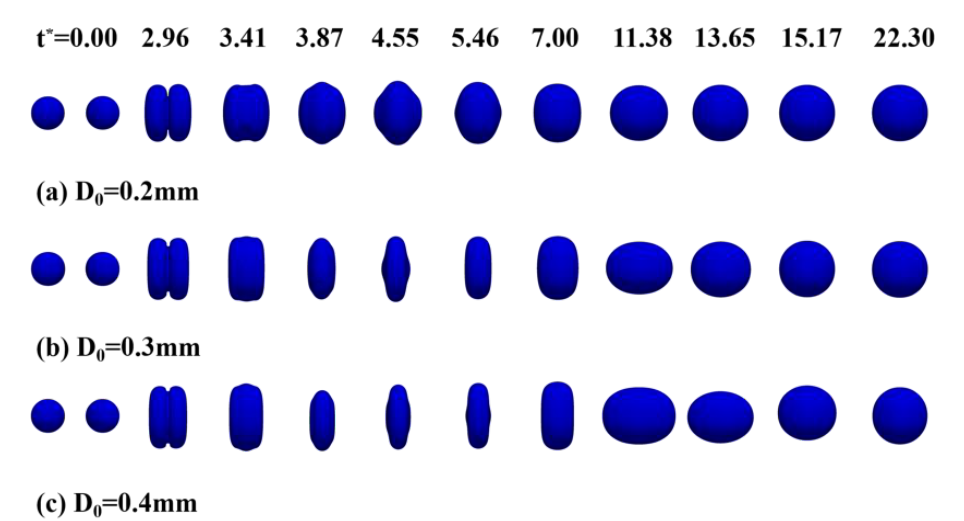
Figure 7. Time evolution of two water droplets coalescence in the oil phase under different initial droplet diameters ( a ) D 0 = 0.2 mm, ( b ) D 0 = 0.3 mm, ( c ) D 0 = 0.4 mm.